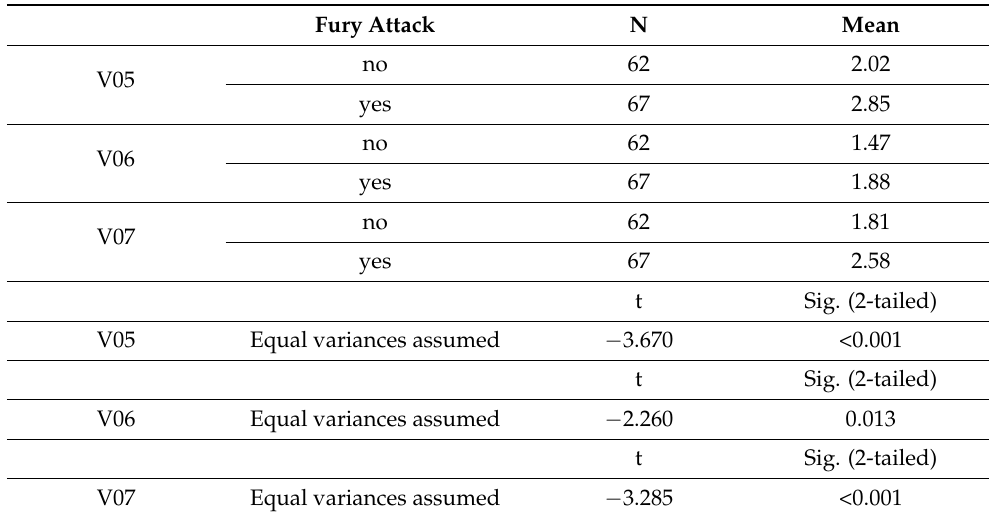
Table 13. Comparison (considering V05. V06 and V07) between those who did not have a perception of fury attack (no) and those who had the perception of fury attack (yes). Fury